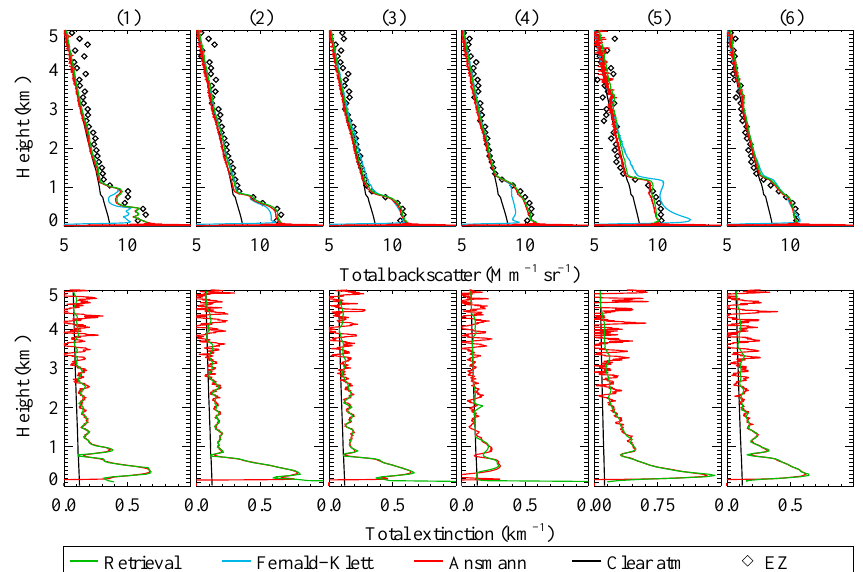
Fig. 13. Various estimates of total backscatter (top) and two-way extinction (bottom) for six analogue profiles observed by the CUV during March 2010. The attenuated backscatter coefficient β exp [− 2 (χ + σ ( L ) R N )] reported by the EZ lidar is shown in diamonds for comparison to the total backscatter. The scattering that would be observed from a clear atmosphere is shown in black, highlighting negative α returned by the Ansmann technique (which operated at 150m resolution).